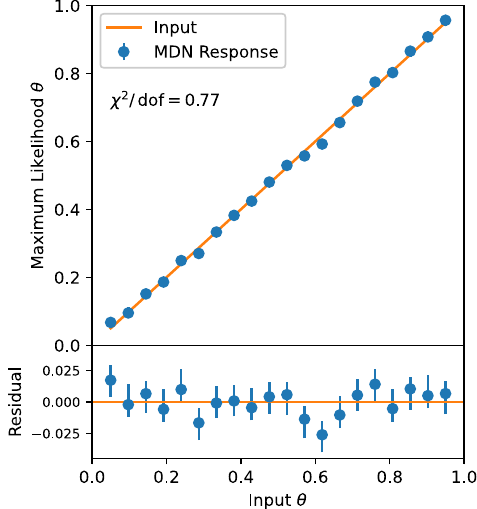
Fig. 10 Maximum likelihood estimator for parameter value θ ML , and associated statistical uncertainties estimated using Wilks’ theorem, for samples generated at various values of true θ . No bias is observed